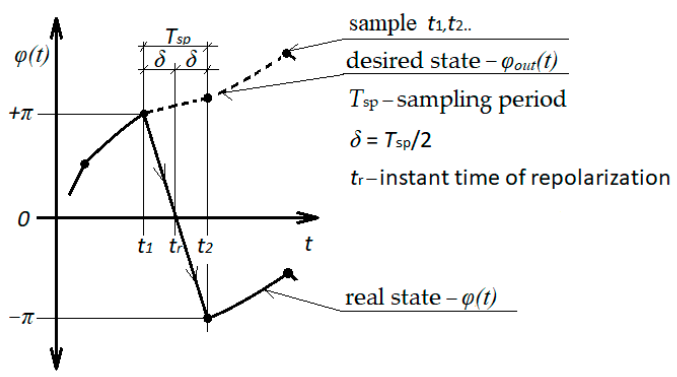
Figure 7. Plotted repolarization of rotation in the joint.